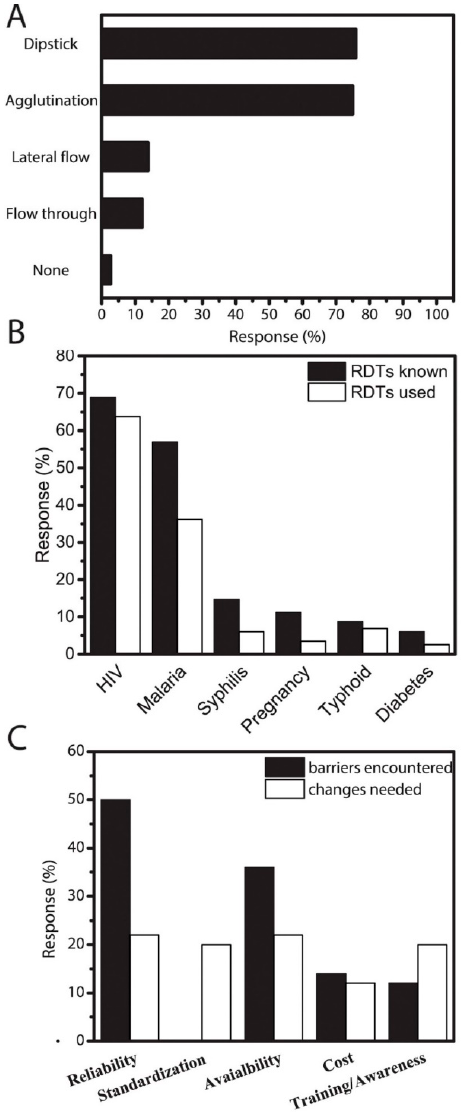
Figure 3. Feedback on knowledge, use and challenges in adoption of RDTs: ( A ) knowledge about specific technologies for RDTs; ( B ) percentage of clinicians that had heard about (black) or used (white) RDT for a specific disease—multiple answers possible; and ( C ) barriers encountered and perceived changes needed in RDTs. The large difference in “reliability” comes from doctors indicating both reliability and standardization, which will make results more reliable, as a change to unreliable RDTs.